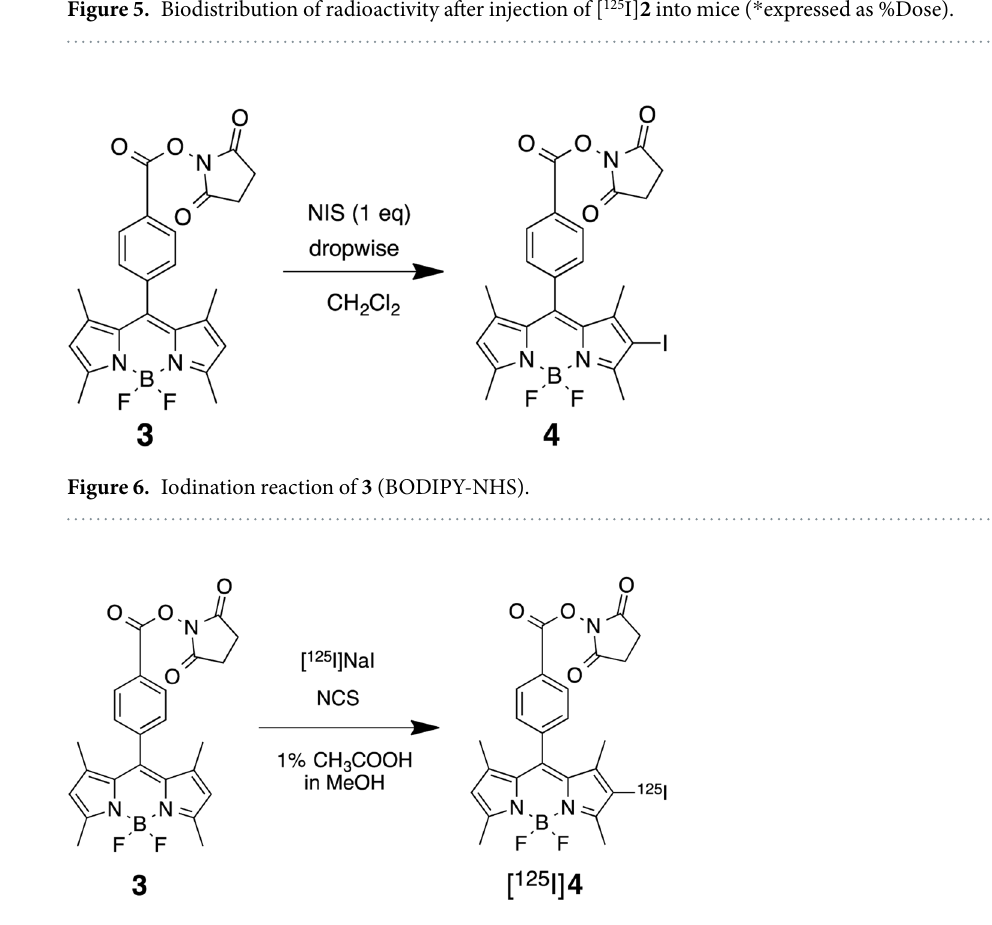
Figure 7. Radioiodination reaction of 3